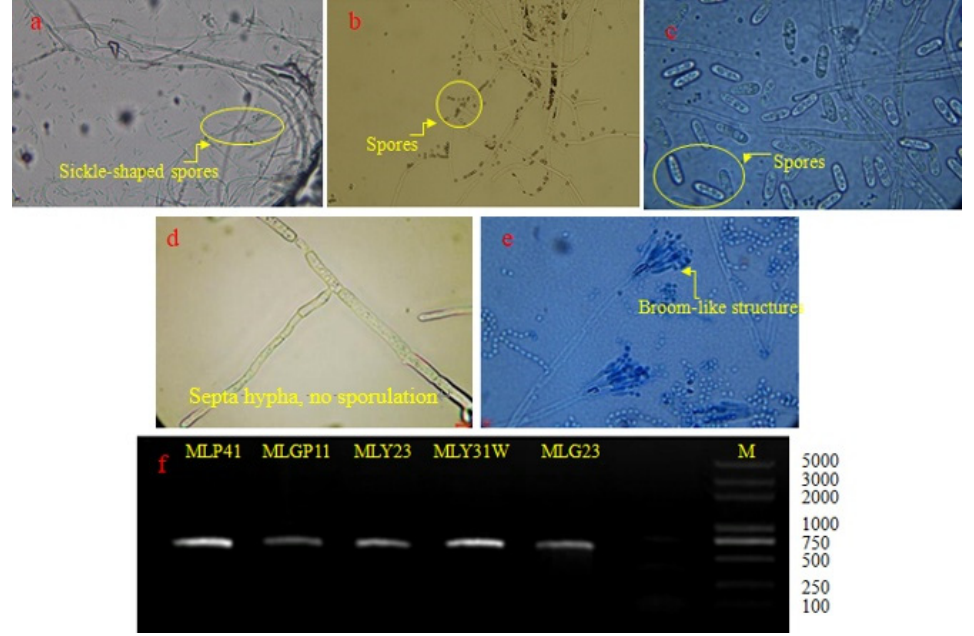
Figure 2. Morphological features of ( a ) MLP41, ( b ) MLG23, ( c ) MLY23, ( d ) MLY31W, and ( e ) MLGP11 under a microscope (1000× magnification), and ( f ) agarose gel electrophoresis of PCR products. Table 1. Biological identification results of the five selected endophytic fungi.